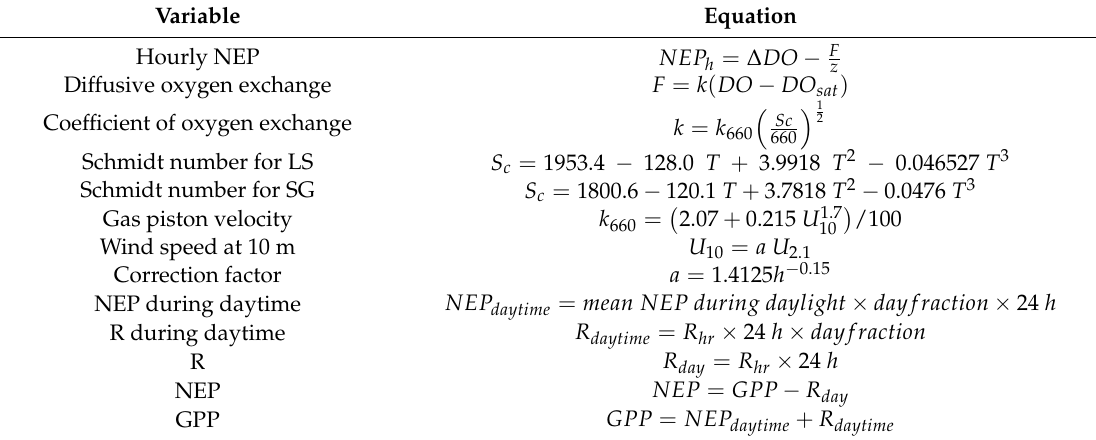
Table 1. Equations for the estimation of ecosystem metabolism in the La Salada (LS) and Sauce Grande (SG) lakes during the study period. NEP: net ecosystem production; GPP: gross primary production; R: ecosystem